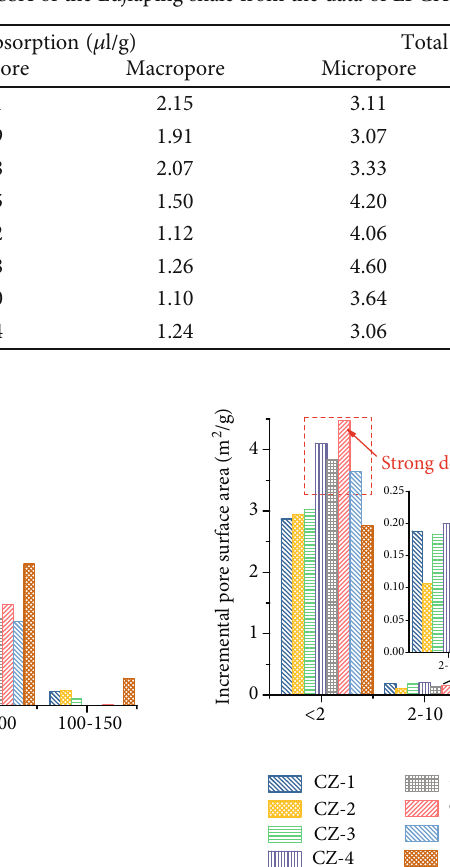
Table 2: Total PV and SSA of the Lujiaping shale from the data of LPGA experiments.